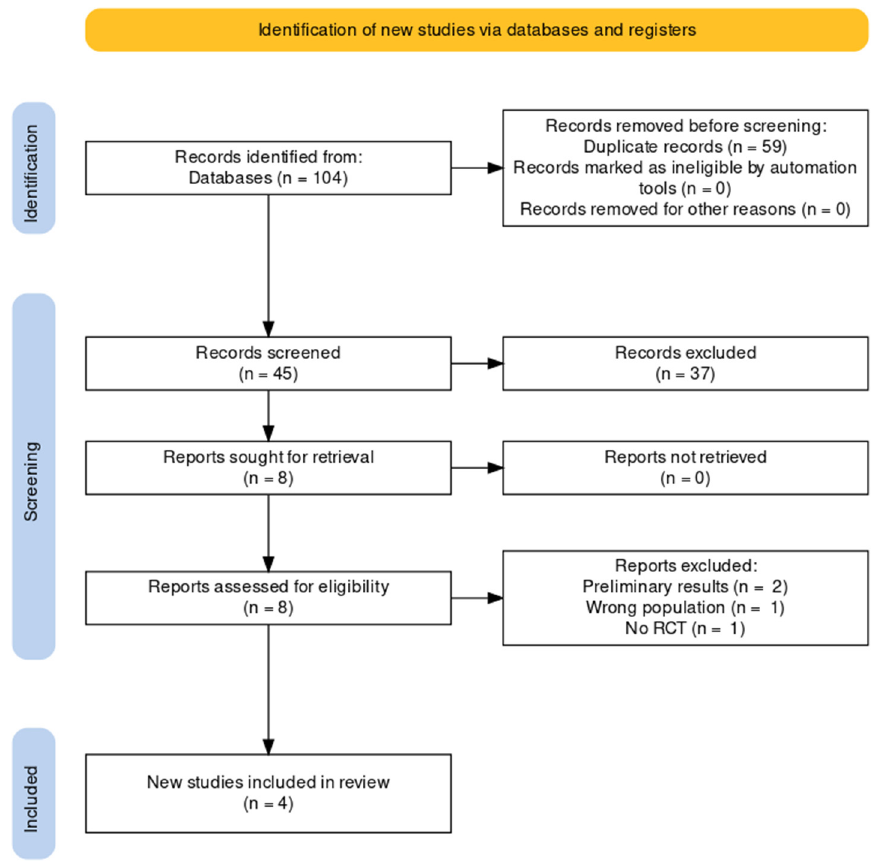
Figure 1. PRISMA flow diagram.